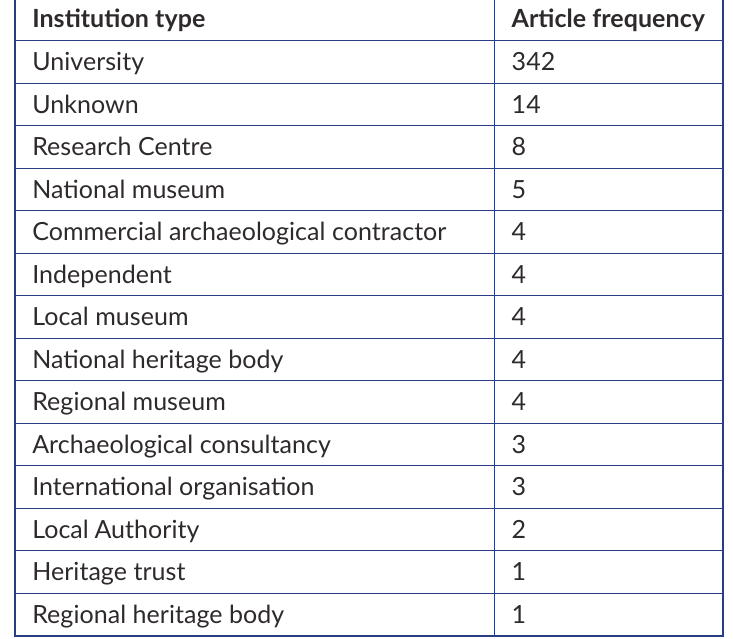
Table 2: Institution types of publication authors (all